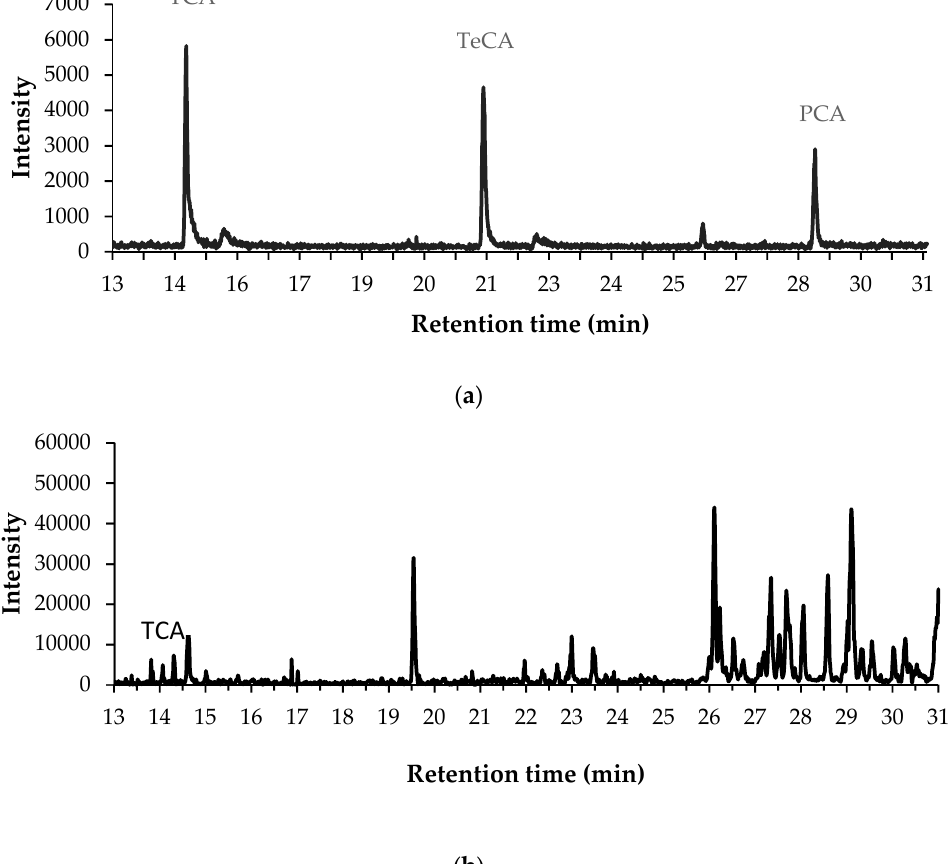
Figure 2. ( a ) Extracted chromatogram ( m / z 210,212,229,231,246,265,267) for a standard solution (35 µg·L − 1 ) prepared in hexane and directly injected into the GC; ( b ) extracted chromatogram ( m / z 210,212) for C1N cork macerate after applying the SPE method.